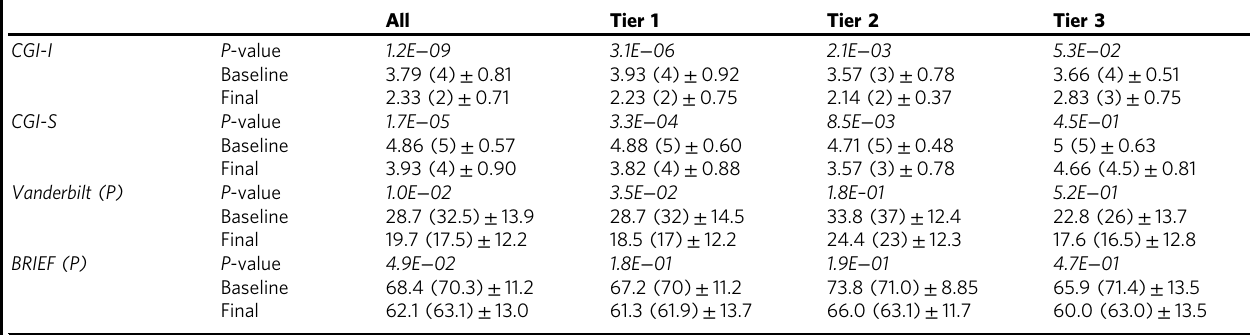
Table 4 Study measure scores for all subjects and strati fi ed by genetic tier